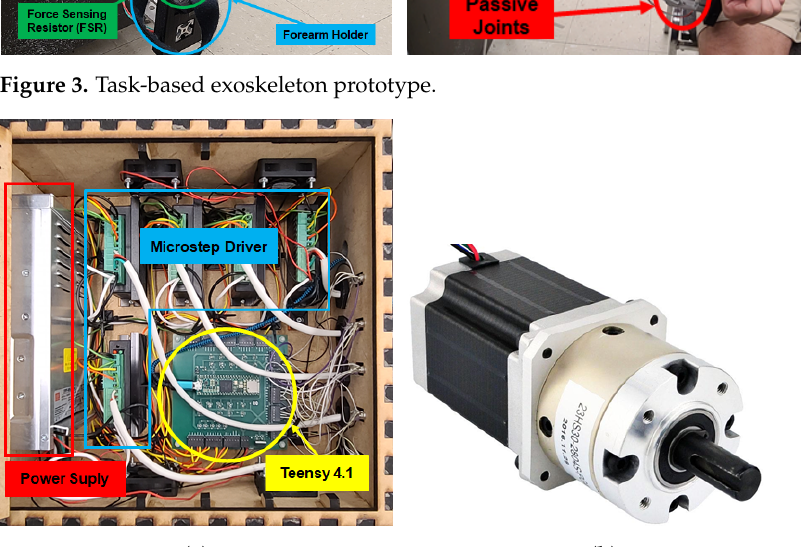
Figure 4. Control Box and NEMA 23 Stepper Motor. ( a ) Control Box. ( b ) NEMA 23 Stepper Motor with 46:1 Planetary